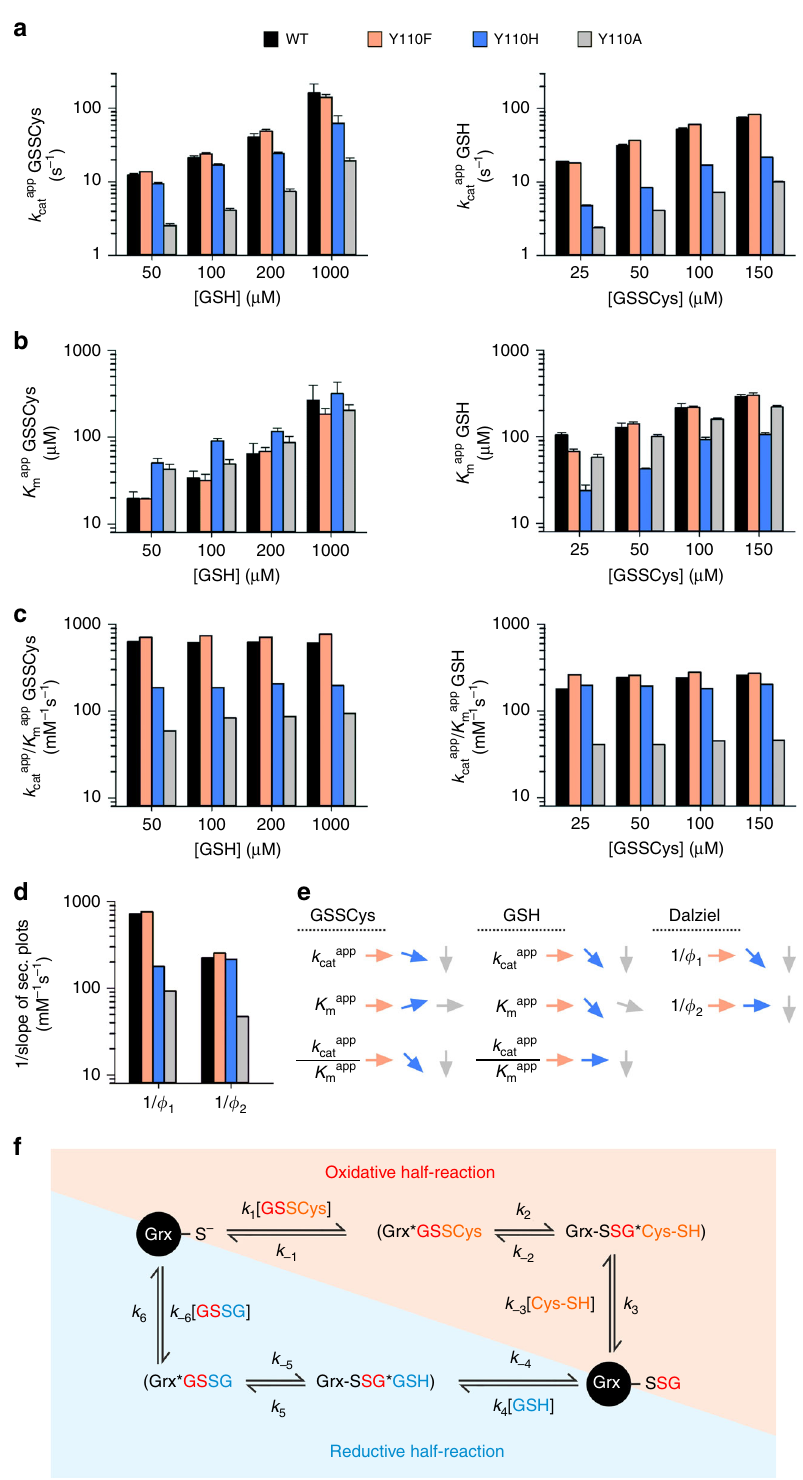
and K app values of ScGrx7 wild-type enzyme and cat m values m values do not re fl ect true substrate m and K app values from panels a and b are listed in cat m